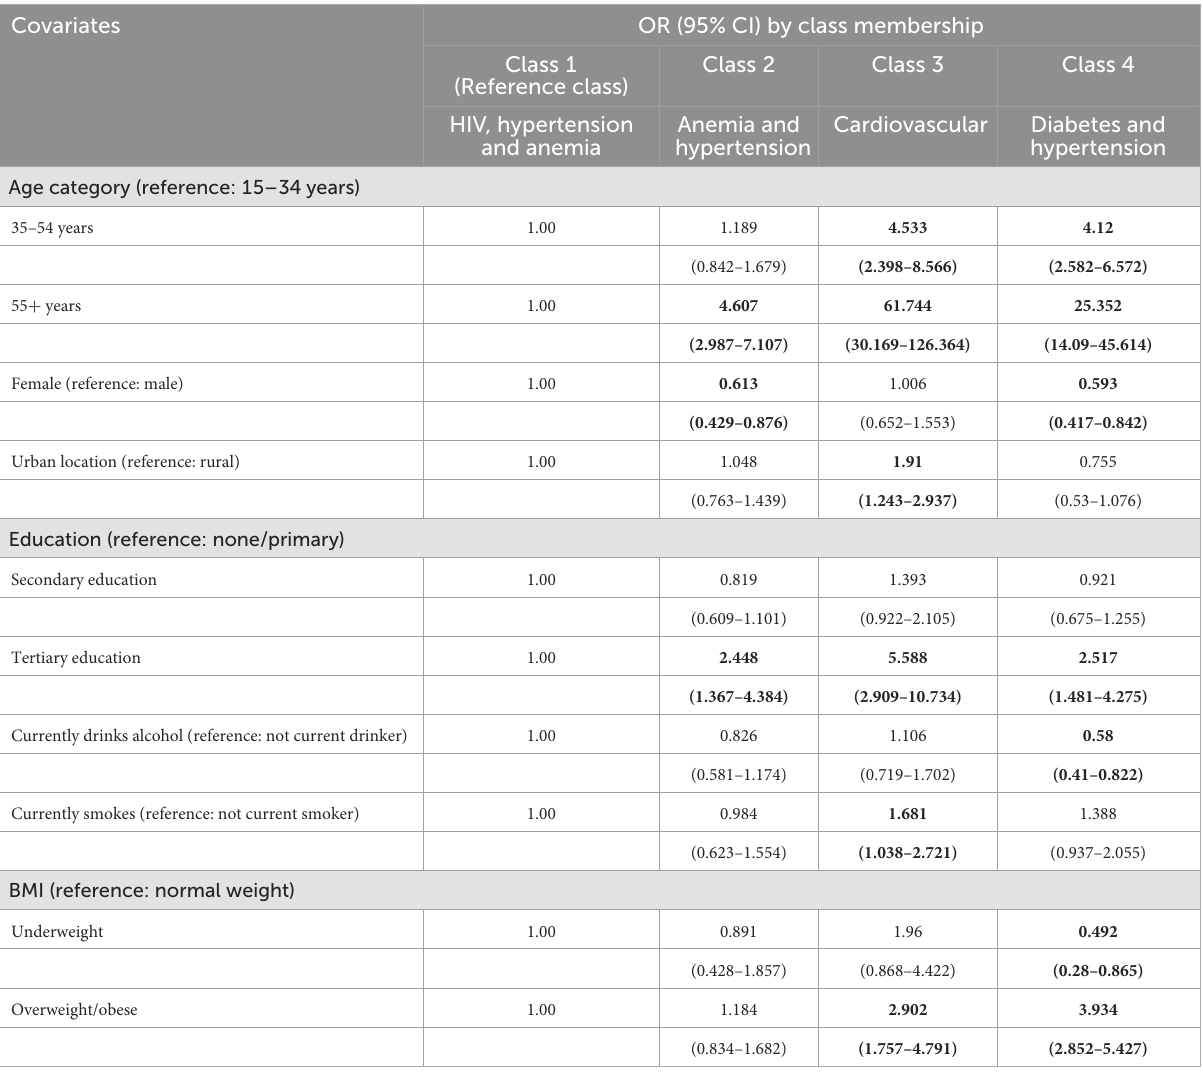
TABLE 4 Factors associated with class